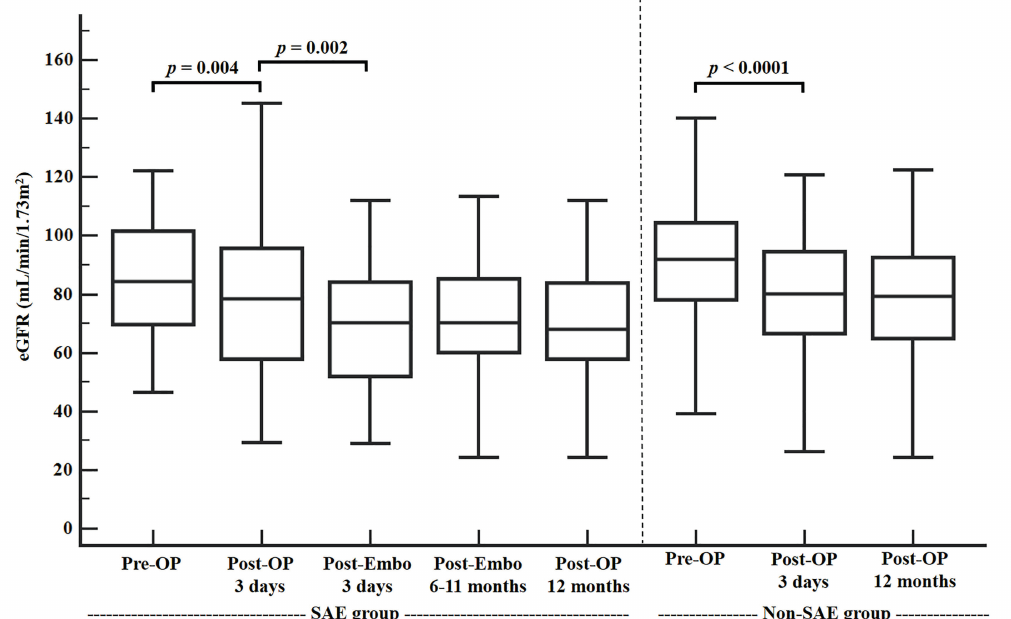
Figure 1 - Mean eGFR values and paired comparison at different time points before surgery, before and after